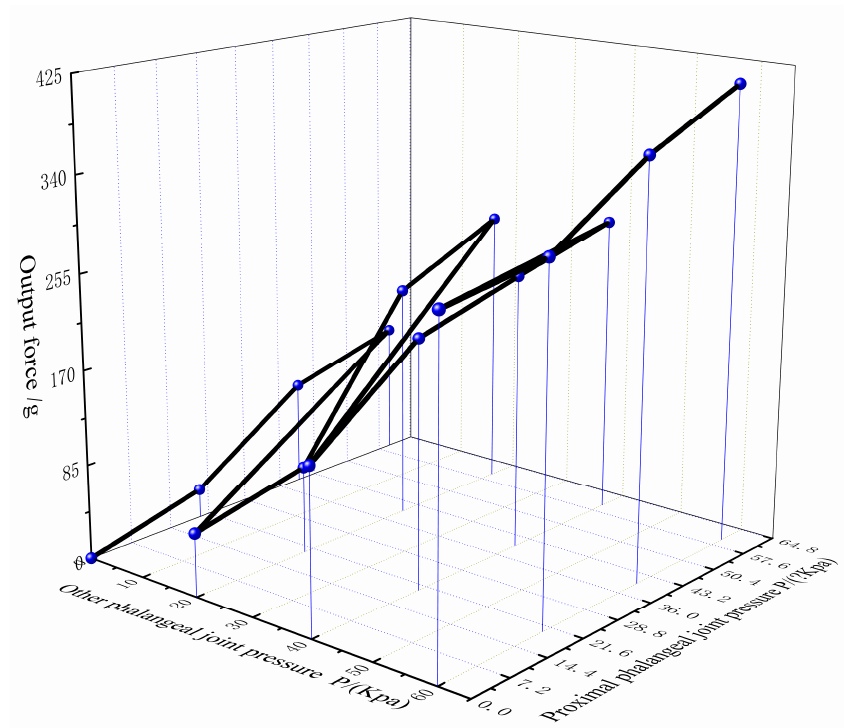
Figure 17. Drive joints to apply air pressure load output force together.